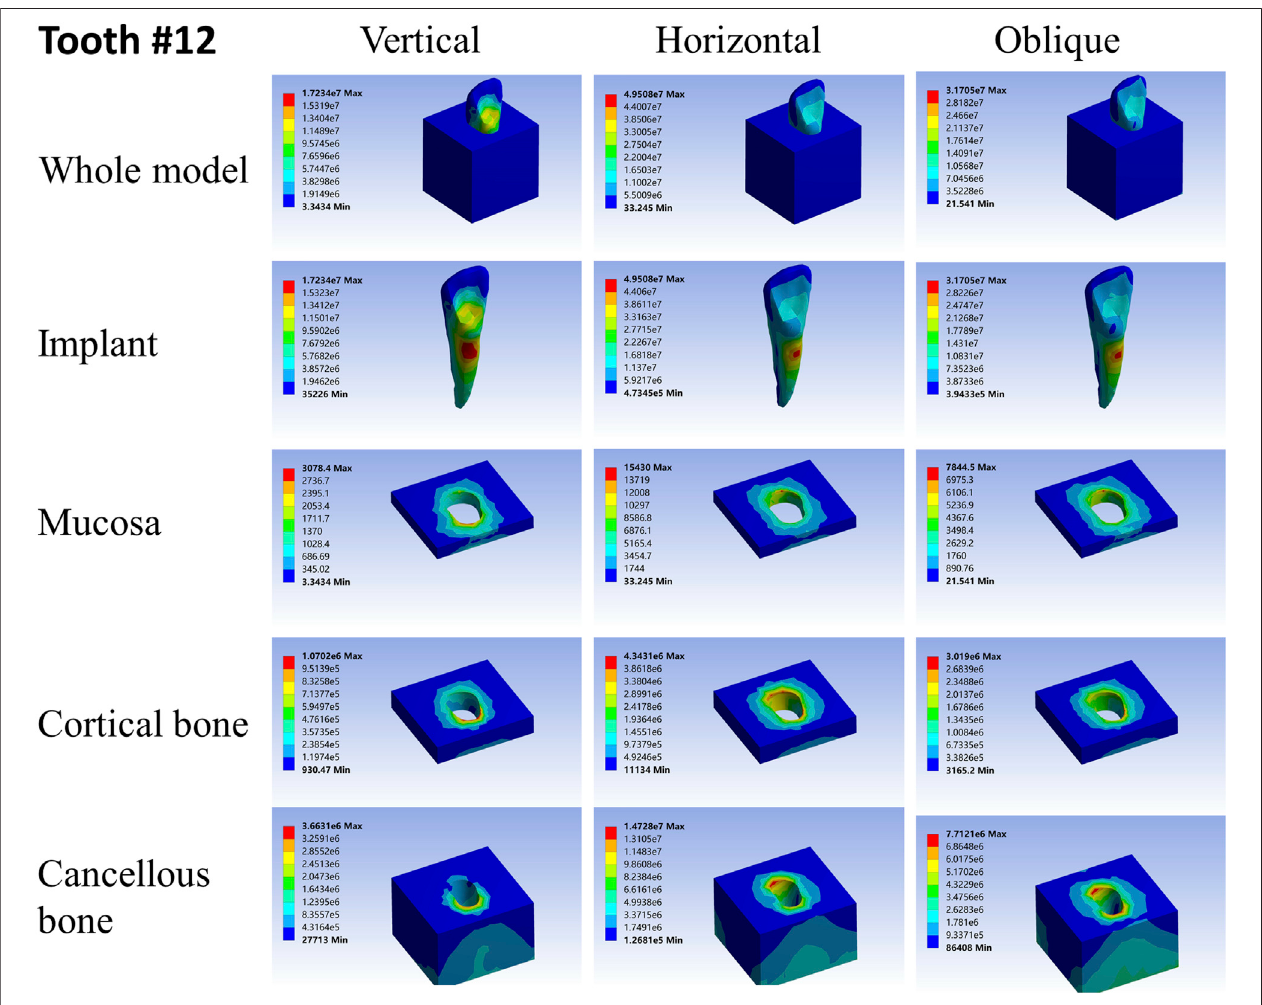
FIGURE 6 | Stress distribution of 12 under 100-N